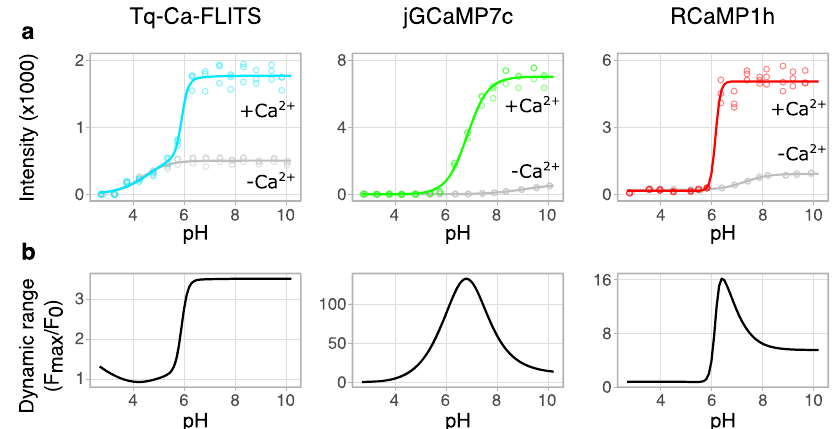
Fig. 4 pH sensitivity of Tq-Ca-FLITS, jGCaMP7c and RCaMP1h in vitro. a Intensity change of the sensors as a response to pH, for the calcium-bound (blue/green/red) and -unbound (gray) state (all n = 3). A Hill curve (line) with one p K a value and Hill coef fi cient was fi tted through the measured data (circles), except for calcium-bound state of Tq-Ca-FLITS where a model with two p K a values was used. b The dynamic range is calculated as a ratio of the models presented in a . The dynamic range of Tq-Ca-FLITS is stable in the biological pH range, whereas it fl uctuates strongly for jGCaMP7c and RCaMP1h. Source data are provided as a Source Data fi